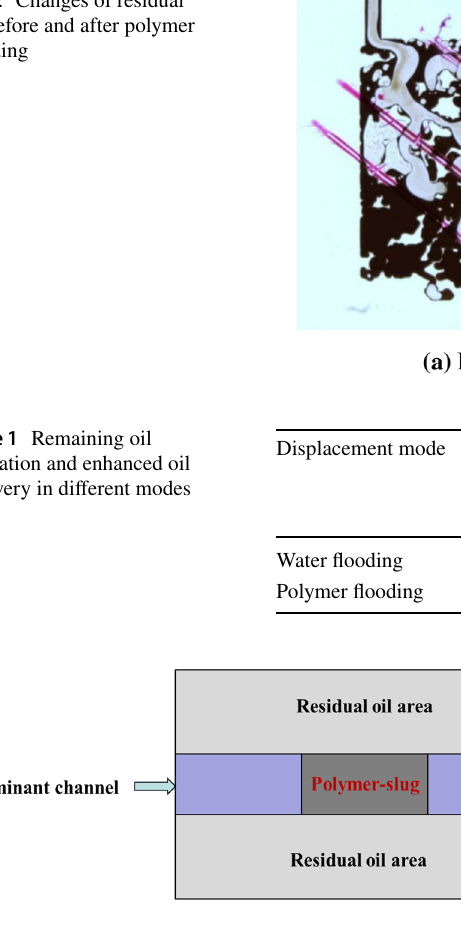
Fig. 3 Schematic diagram of polymer flooding